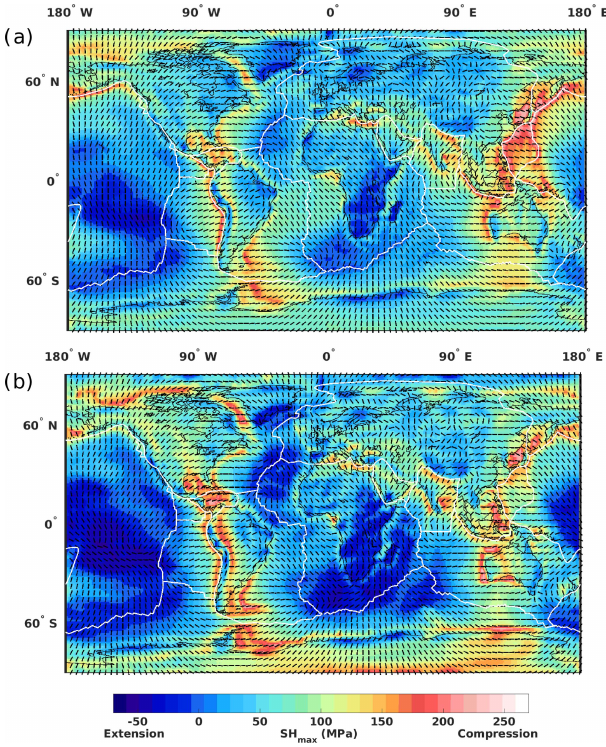
Figure 4. Predictions of the SH max magnitude and direction from combined contributions due to lower mantle flow and upper man- tle from (a) TM1 with crust model and (b) TM2 with crust model beneath air (free